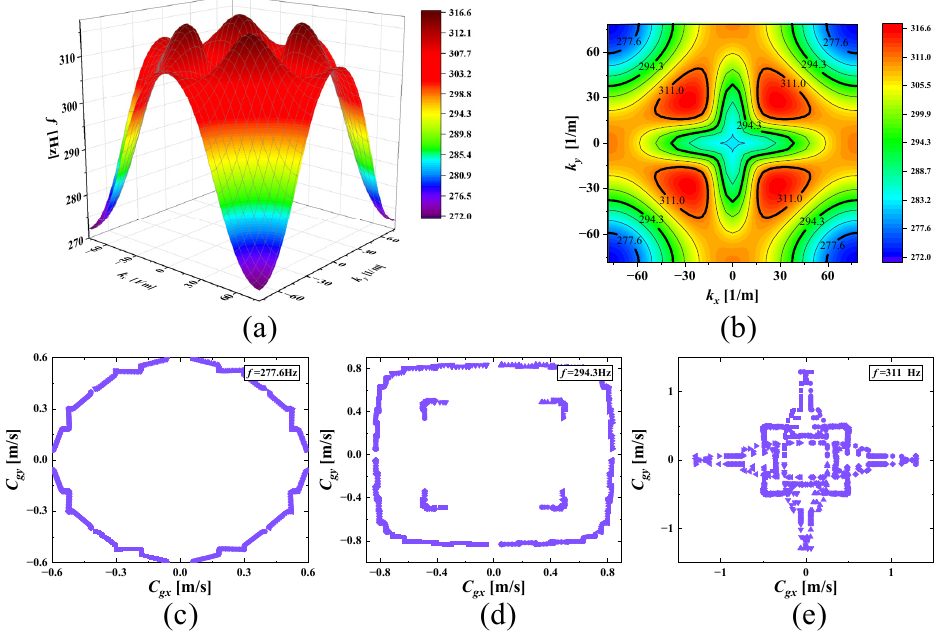
Figure 12. ( a ) Ninth mode; ( b ) ISO-frequency contours; ( c – e ) group velocity of ninth wave mode at 277.6 Hz, 294.3 Hz, and 311 Hz. To be more precise in evaluating the propagation of elastic waves on different dis- persion surfaces, the ISO-frequency contours for the three frequency cases are marked in (b) of Figures 6–12 with heavy black solid lines, and the group velocities corresponding to these ISO-frequency contours are shown in (c,d) of Figures 6–12 respectively. The group